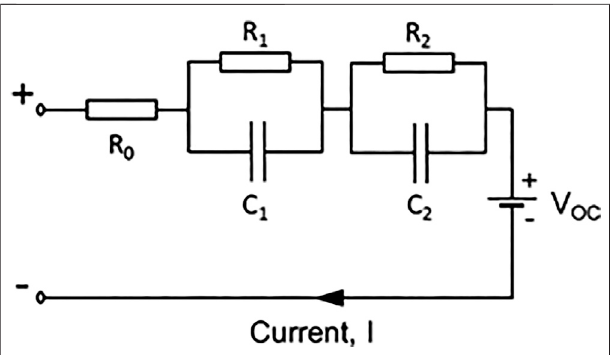
FIGURE 2 | Equivalent circuit of the Ni-Fe